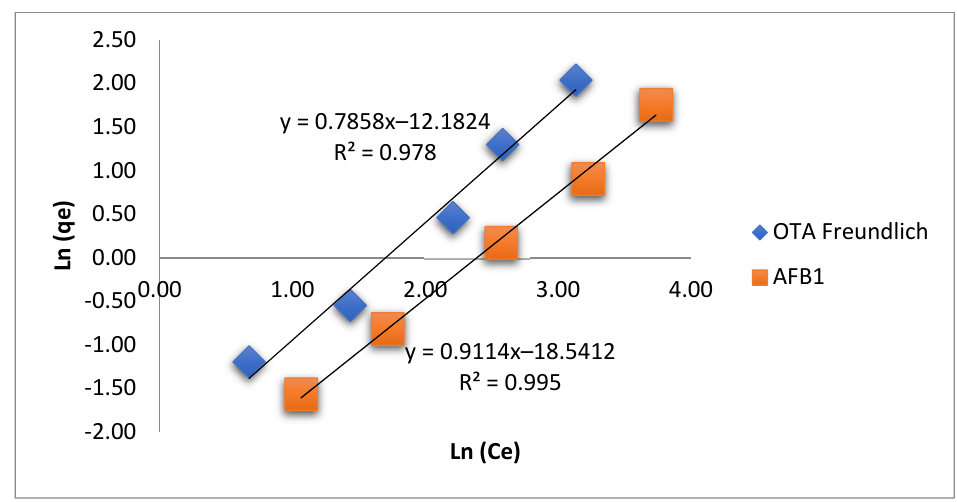
Table 4. Langmuir and Freundlich parameters for the adsorption of mycotoxins with MGO (at 40 °C, 5 h, and pH 5).